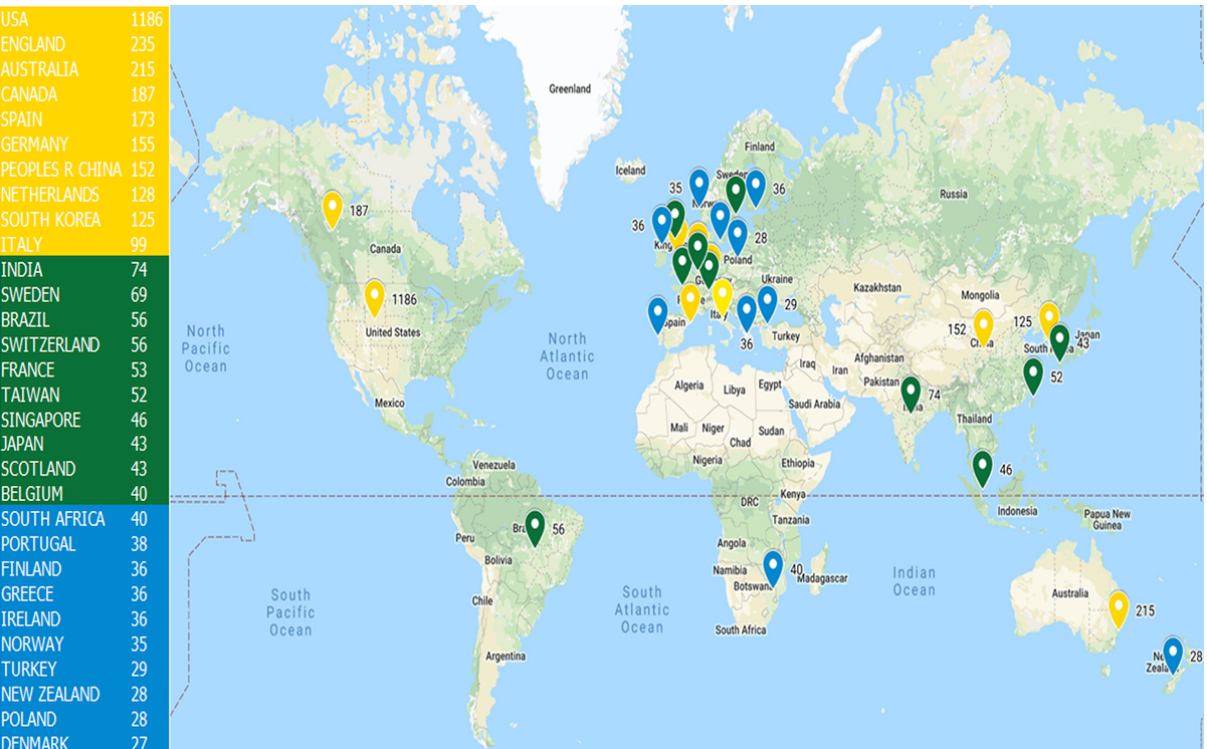
Figure 1. Top 30 countries/regions publishing mobile health app research,